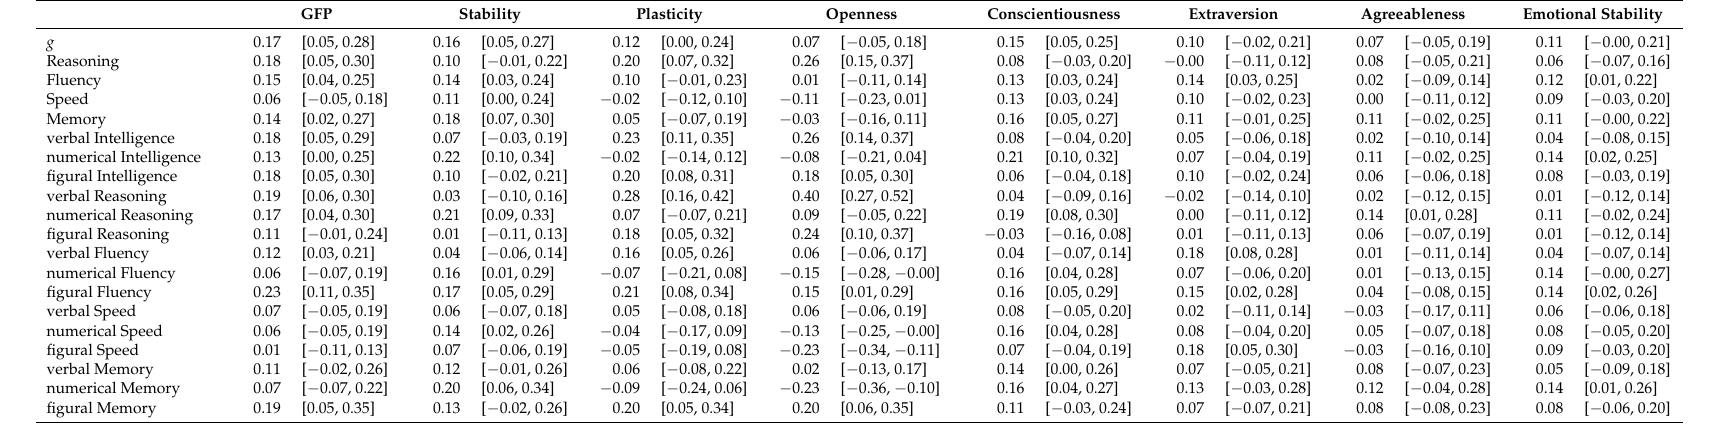
Table A2. Study 2: Bootstrapped disattenuated correlations (controlled for gender). 95% CI in brackets. GFP Stability Plasticity Openness Conscientiousness Extraversion Agreeableness Emotional